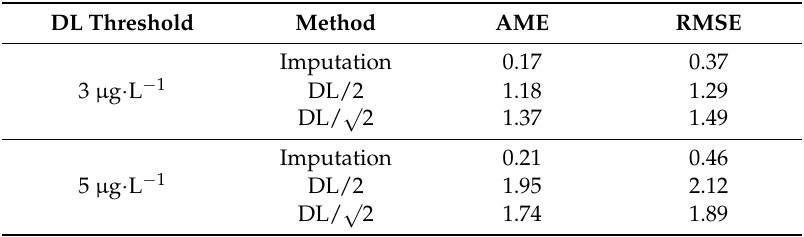
Table 2. Absolute Mean Error (AME) and Root-Squared Mean Error (RMSE) obtained for the imputation and the naive